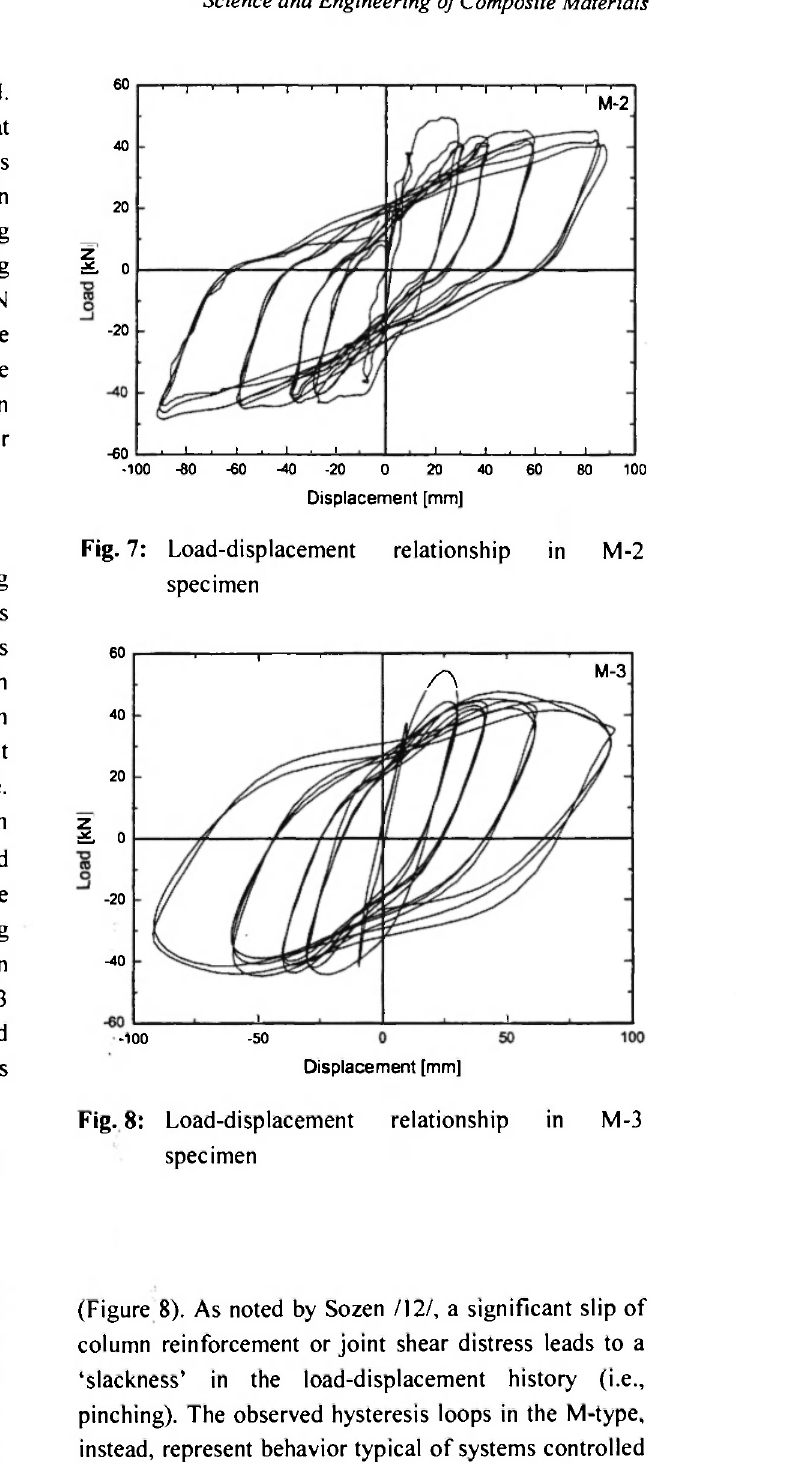
(Figure 8). As noted by Sozen /12/, a significant slip of column reinforcement or joint shear distress leads to a 'slackness' in the load-displacement history (i.e., pinching). The observed hysteresis loops in the M-type, instead, represent behavior typical of systems controlled by flexural response leading fat force-displacement loops. The hysteresis loops for the M-type showed very good energy dissipating characteristics and stability compared with S-type specimens. Clearly, more energy was dissipated for the dynamic loading test rather than the static loading